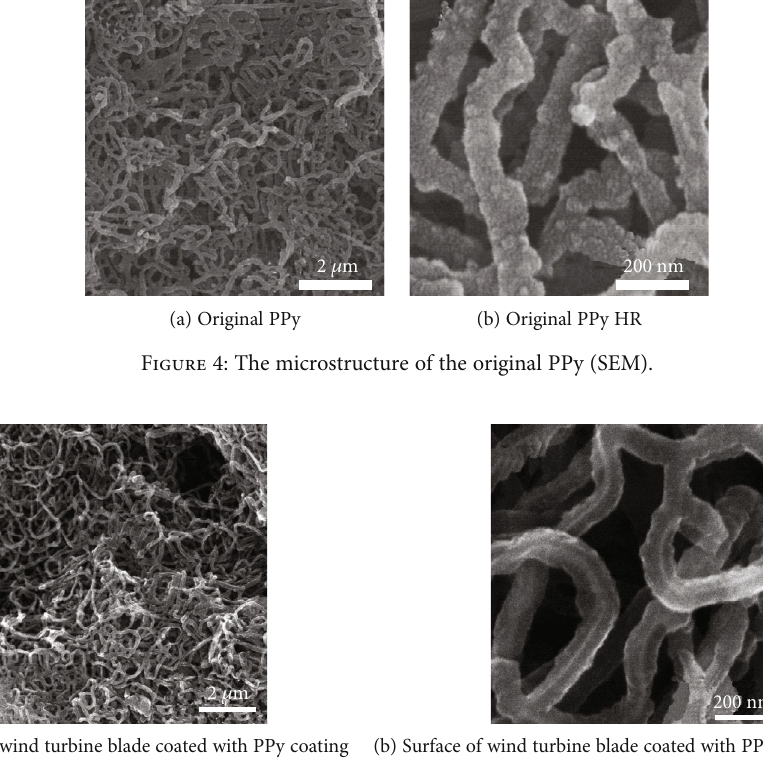
Figure 5: The microstructure of the wind turbine blade surface with PPy coating